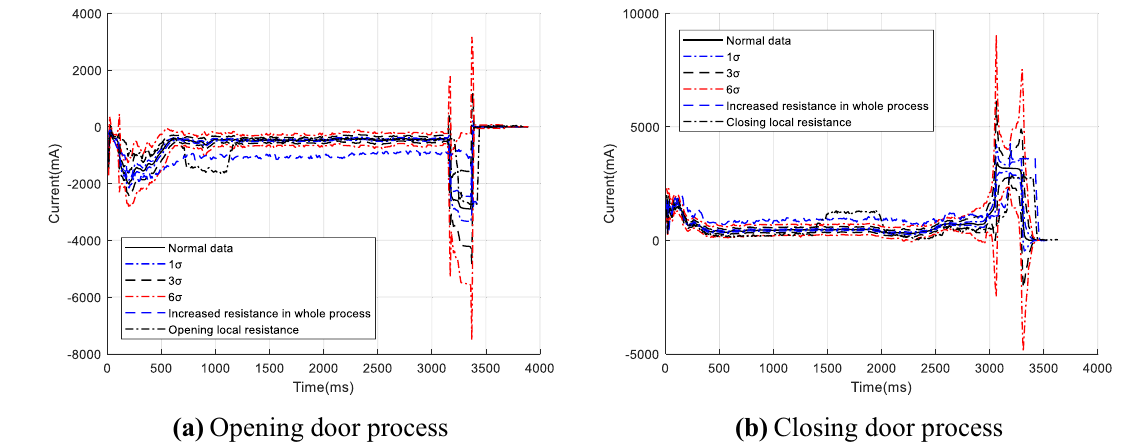
Fig. 7 Comparison of abnormal resistance and normal data